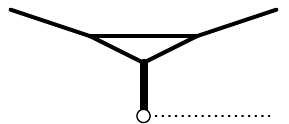
Figure 17. A standard 5- brane web diagram for the E 0 theory.